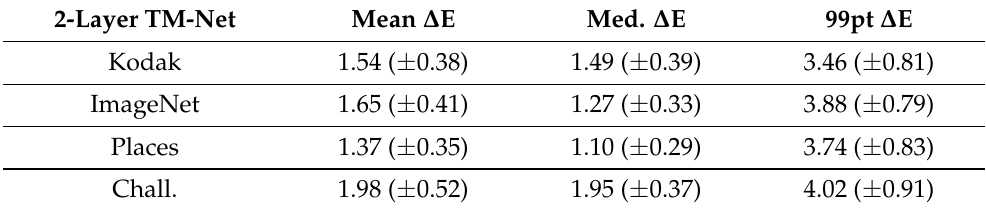
Table 2. Mean ( ± standard deviation) of the mean, median, and 99-percentile of ∆ E for enhanced images compared to HMF , averaged over each image in the